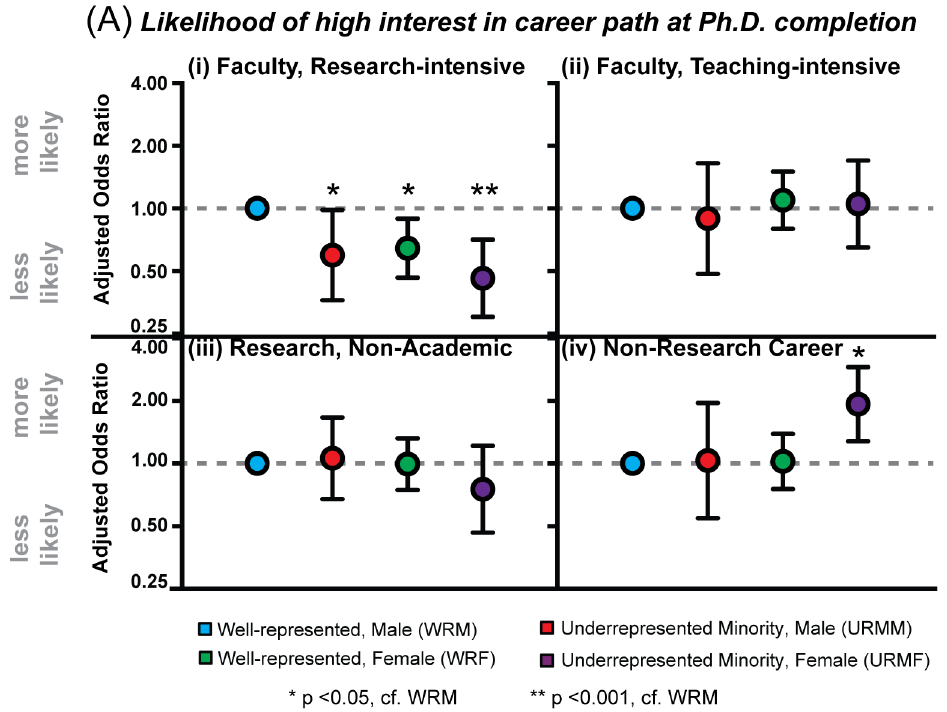
Fig. 2. Disparate Career Interest Profiles Across Social Identity. (A) Plot of adjusted odds-ratio (circle) and 95% confidence interval, with males from well-represented racial/ethnic backgrounds (WRM) as the reference group, showing likelihood of expressing high interest (i.e. 4 or 5 on the 5-point interest scale) in four career paths at Ph.D. completion: (i) faculty at a research-intensive university, (ii) faculty at teaching-intensive university, (iii) a non-academic research career, and (iv) a non-research career. Odds ratios are adjusted for personal dispositions (level of interest in career path at Ph.D. entry, intention to pursue faculty career at Ph.D. entry, and confidence in ability as an independent researcher), objective measures (rate of first-author publications, h-index, time-to-Ph.D., Ph.D. institution type), and graduate training experiences (socialization measures, advisor interactions, and career development